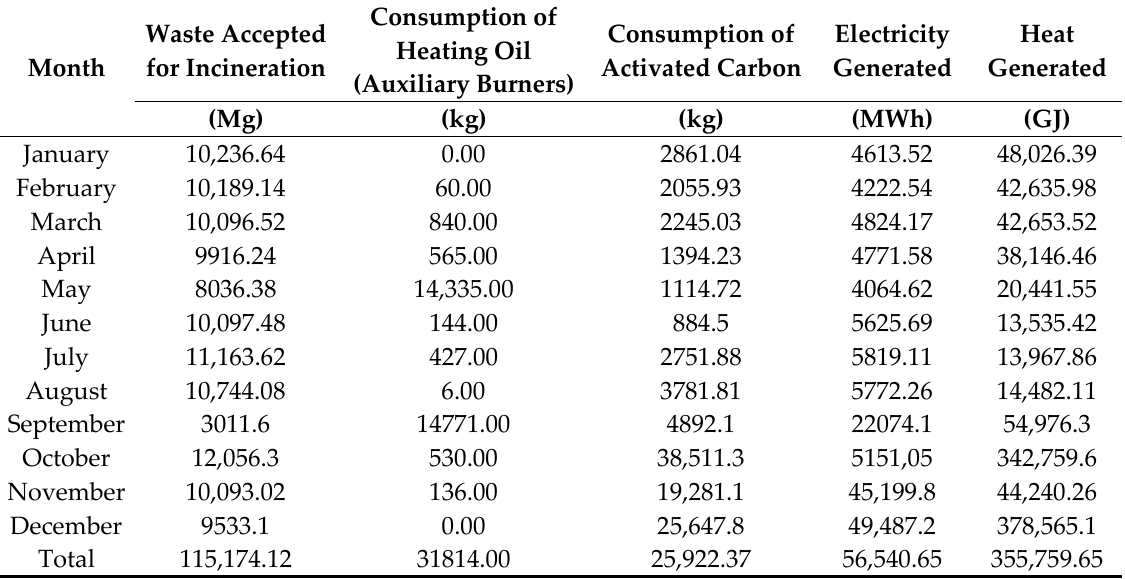
Table 1. Quantities characterizing thermal waste treatment—data for